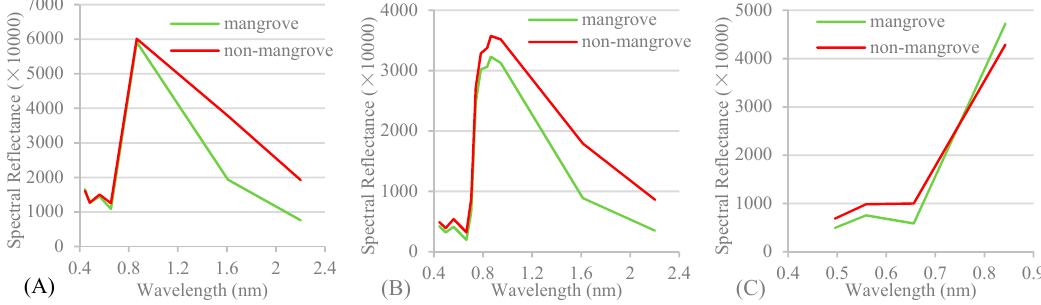
Figure A2. The spectral reflectance of mangroves and non-mangroves in ( A ). Landsat 8, ( B ). Sentinel-2 and ( C ). Pléiades-1 in level 2, which was produced based on 60 representative samples per class.